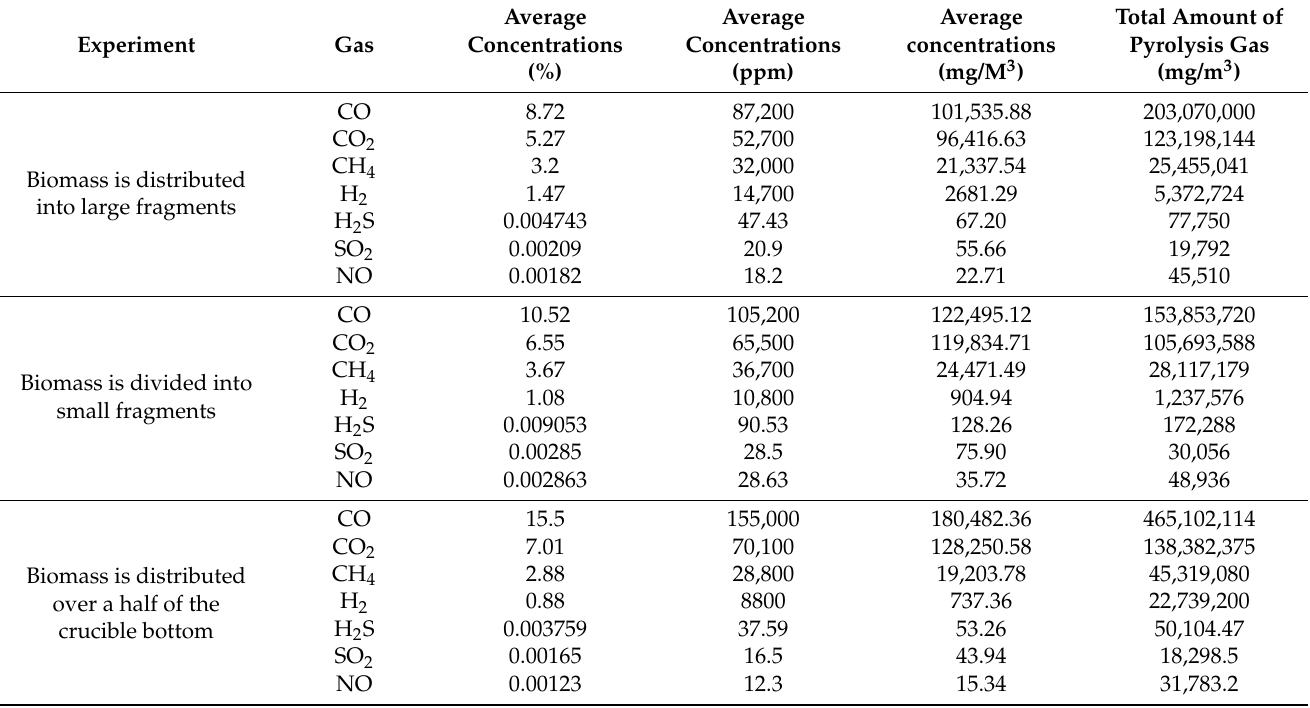
Table 5. The yield of the main